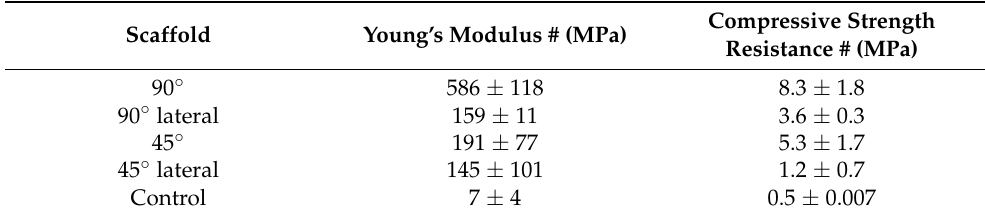
Table 2. Mechanical properties of scaffolds with different printing directions in comparison to the control.